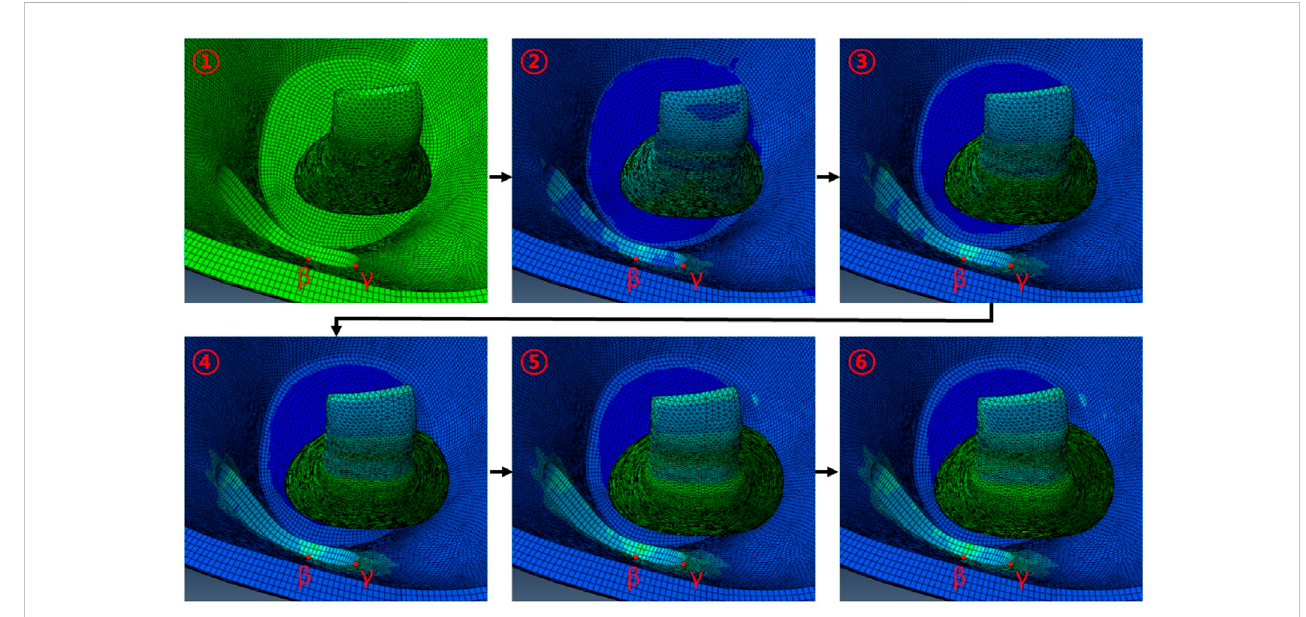
FIGURE 7 Behavior associated with IR hypertrophy in FEA following circular orbital wall removal of diameter 11 mm.